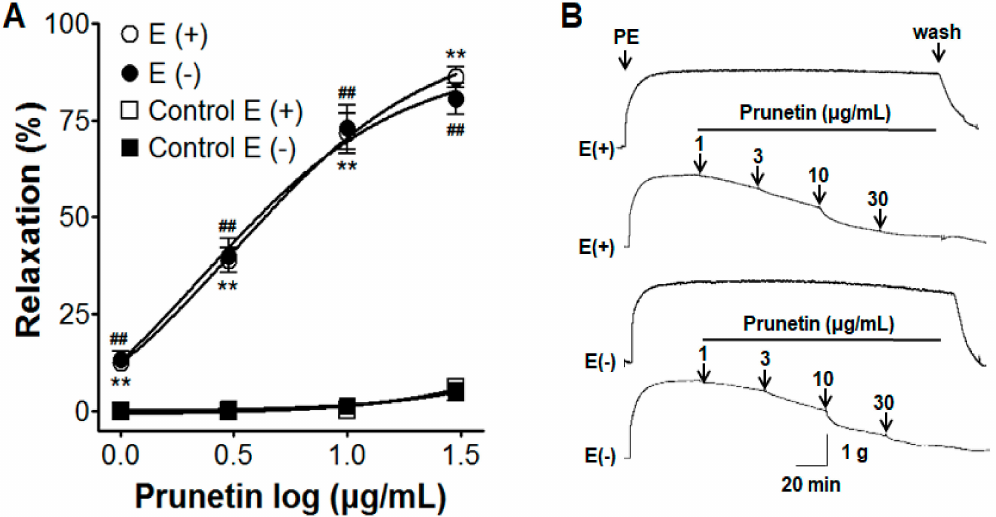
Figure 1. The concentration-response relaxation effect of prunetin on aortic rings pre-contracted by phenylephrine (PE, 1 µ M) ( A ) with [(E+)] or without [(E − )] vascular endothelium; ( B ) Representative traces under the indicated conditions. Values are expressed as mean ± standard error of mean (SEM) ( n = 4). ** p < 0.01, ## p < 0.01 vs.